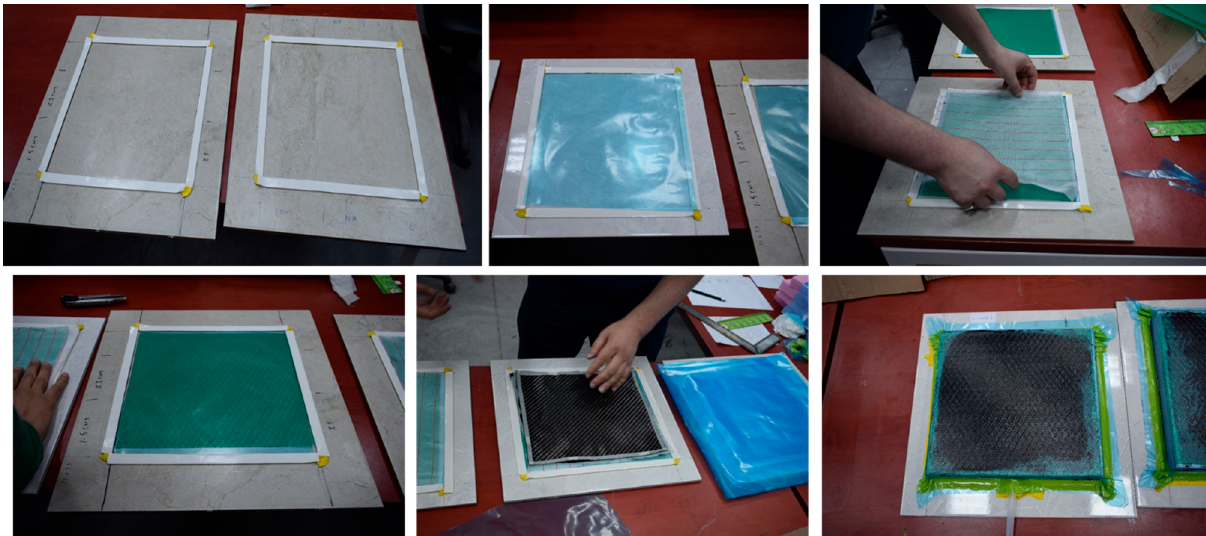
Figure 2. Manufacture of CNTRC composite material.